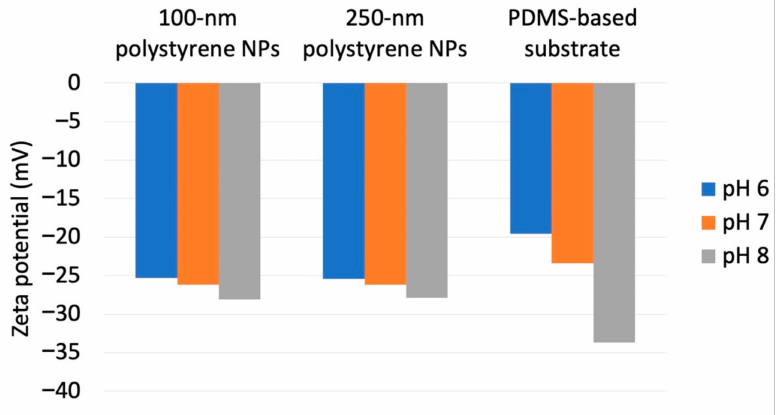
Figure 4. Zeta potentials obtained for different nanoparticle dimensions and dispersion medium pH.